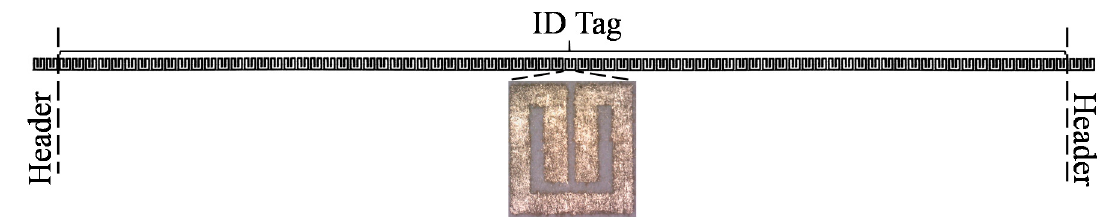
Figure 5. Photograph of the 80-bit tag fabricated on ordinary paper, with all bits set to ‘1’ and with header bits.